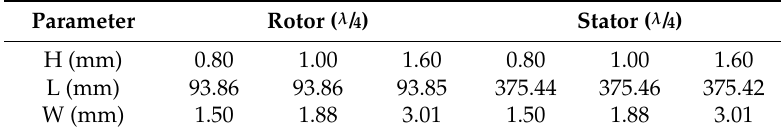
Table 2. Length L and width W of the micro strip transmission lines calculated as a function of the thickness H of the FR-4 substrate.